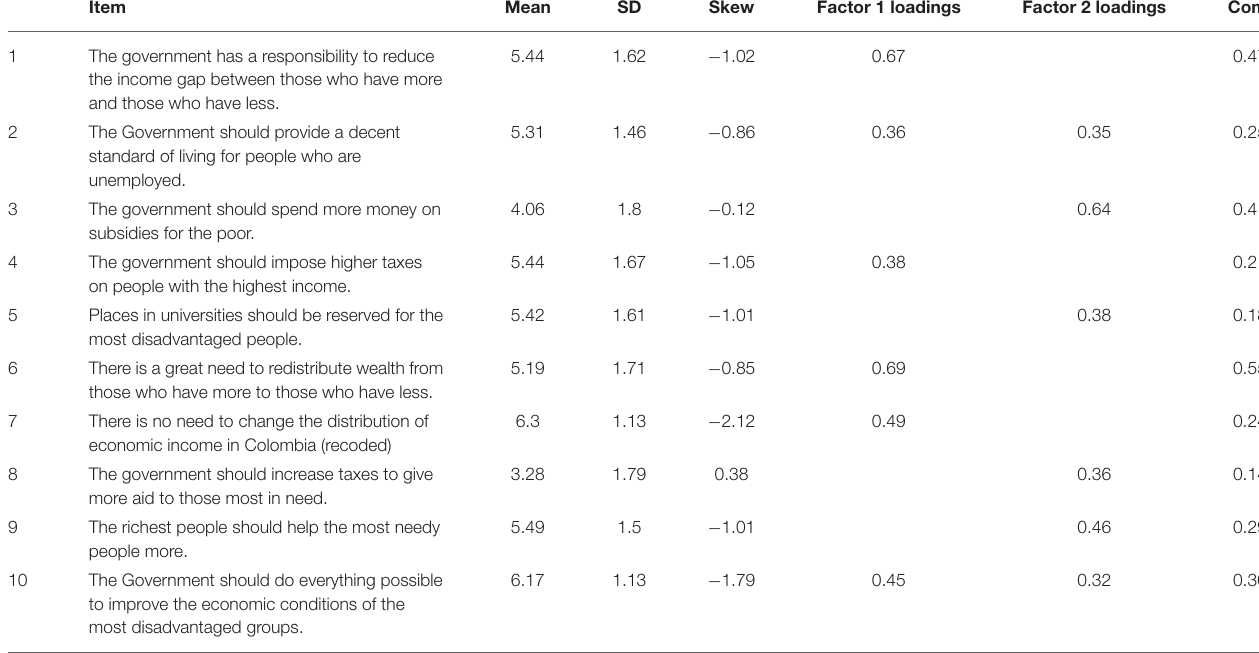
TABLE 1 | Descriptive statistics and factor loadings of the exploratory factor analysis for the scale of support for redistribution (Study 1). Item Mean SD Skew Factor 1 loadings Factor 2 loadings